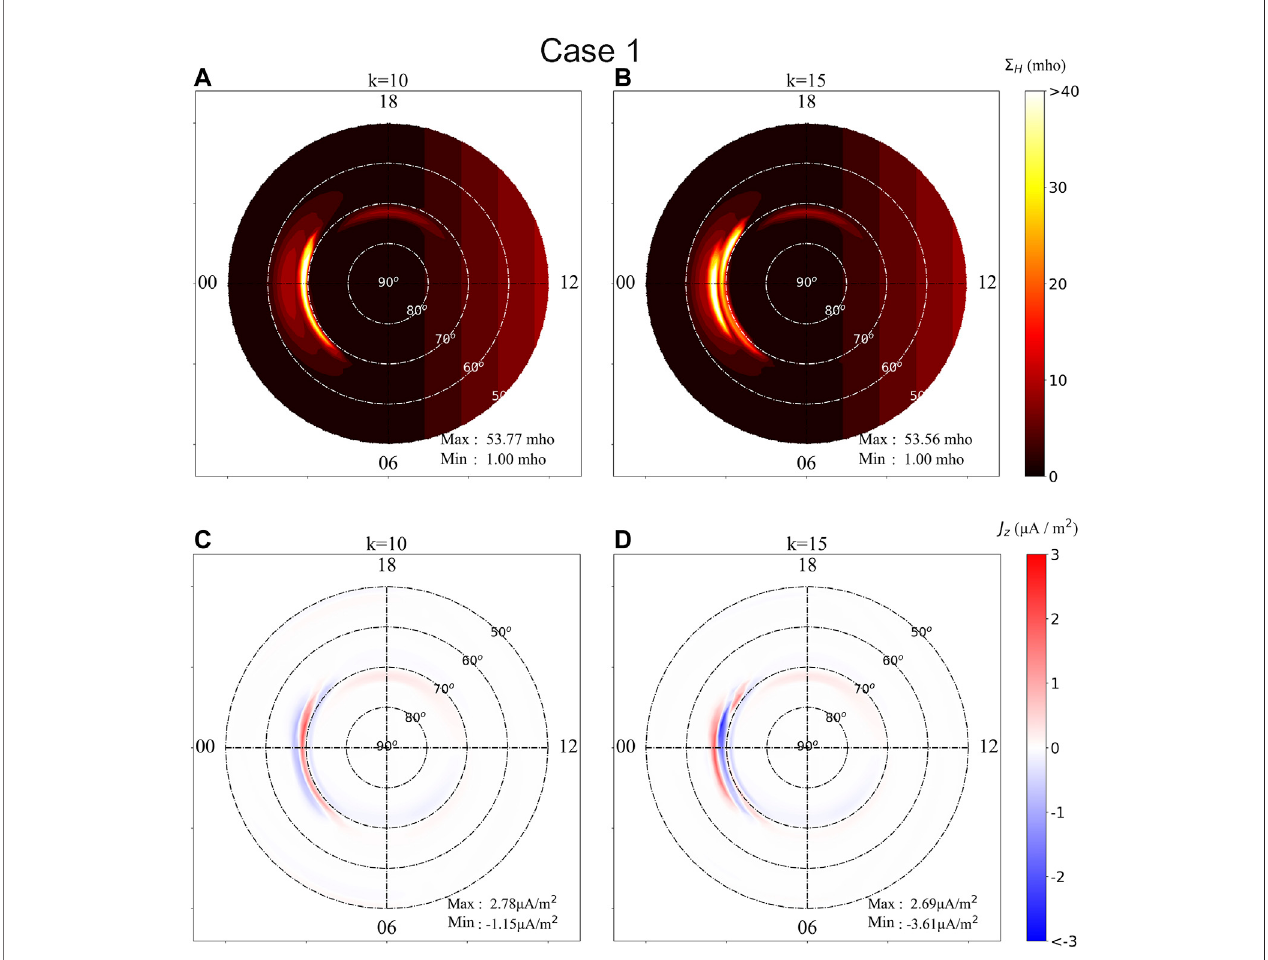
(cid:1) 54 ° .Panels (A) and (B) distributionswith λ R m (cid:1) 0 PS